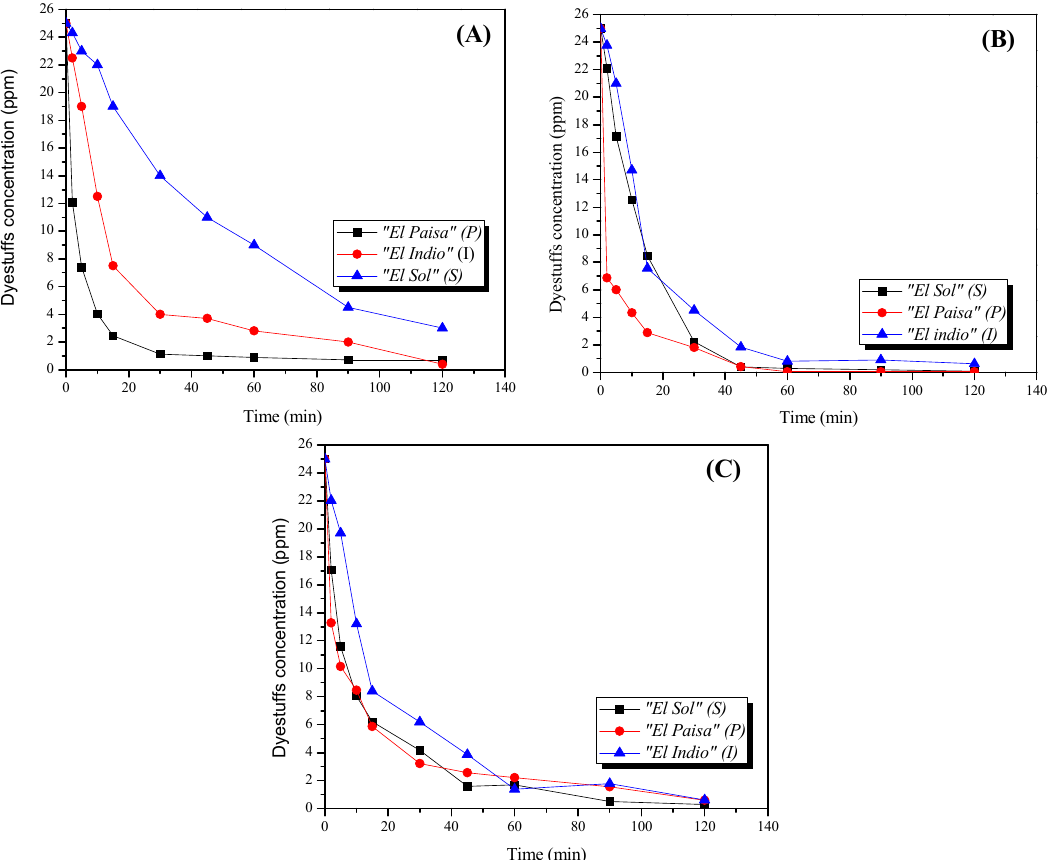
Figure 12. Evolution of the dyestuffs concentration with the photoreaction time over the photocatalysts analyzed. ( A ) P25; ( B ) F-P25 and ( C ) Pt-F-P25.